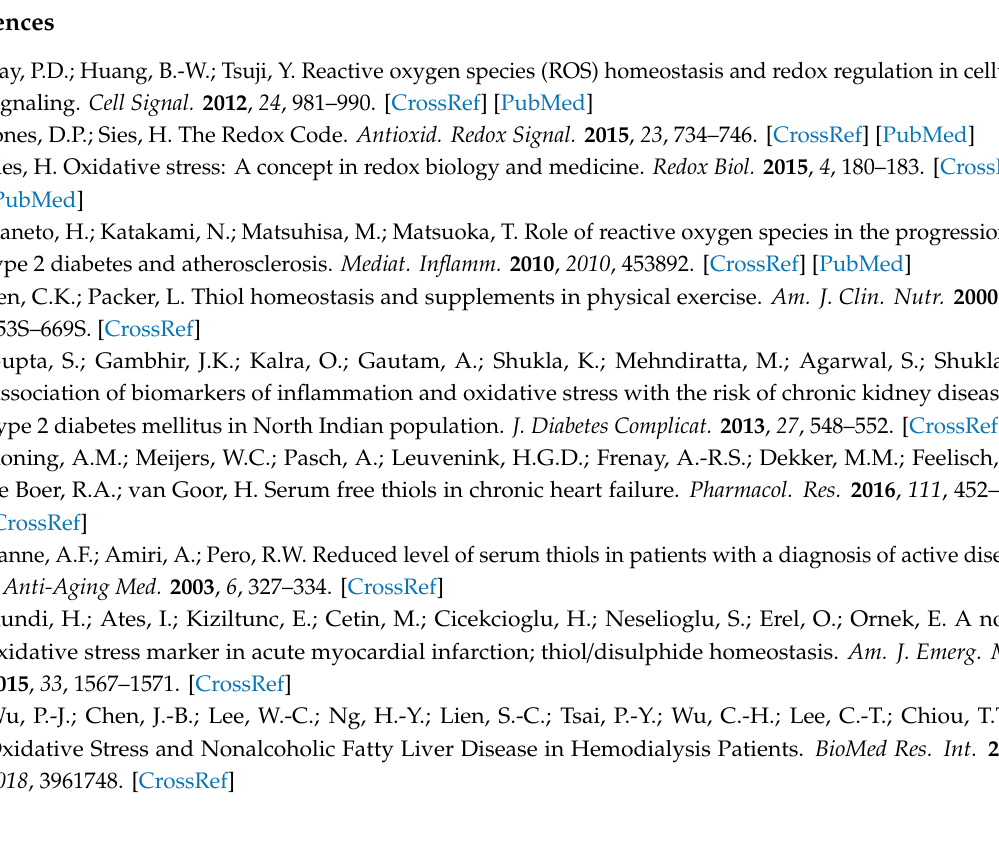
Table S1: Univariate relationships of plasma free thiols with clinical and laboratory variables in males (n = 98) and females (n = 70). Table S2: Multivariable linear regression analysis demonstrating independent associations of plasma free thiols with age and individual metabolic syndrome components in males (n = 98) and females (n = 70). Table S3: Multivariable linear regression analysis demonstrating independent associations of plasma triglycerides with age, sex, free thiols, free fatty acids, PLTP activity and adiponectin and glucose in males (n = 98) and females (n = 70). Table S4: Multivariable linear regression analysis demonstrating independent associations of large very low density lipoprotein subfractions with age, sex, free thiols, free fatty acids, PLTP activity, adiponectin and glucose in males (n = 98) and females (n =